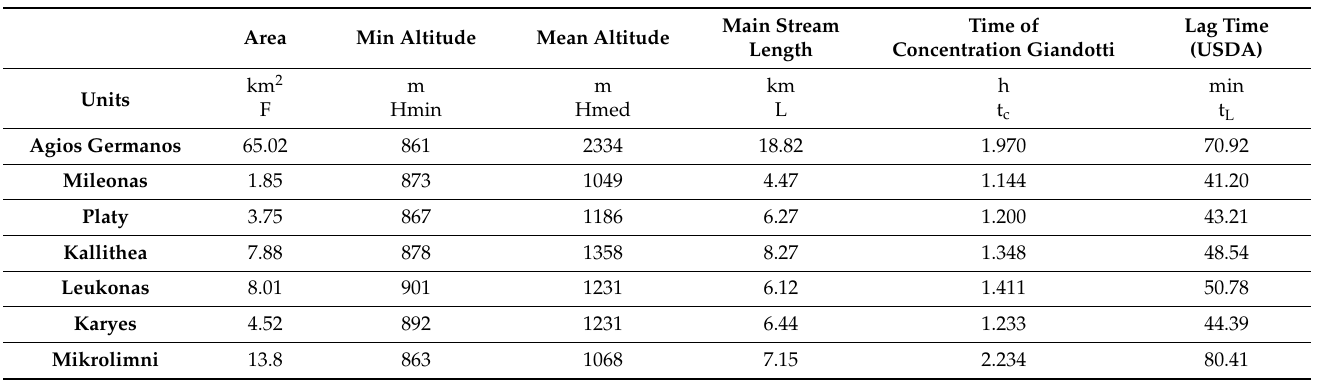
tics, with an exception in Agios Germanos and Mikrolimni watersheds, which exhibited higher values. Table 9. Hydrographic and morphometric characteristics required for the calculation of Giandotti time of concentration and lag time. Main Stream Time of Lag Time Area Min Altitude Mean Altitude Length Concentration Giandotti (USDA) km 2 m m km h min Units F Hmin Hmed t c t L